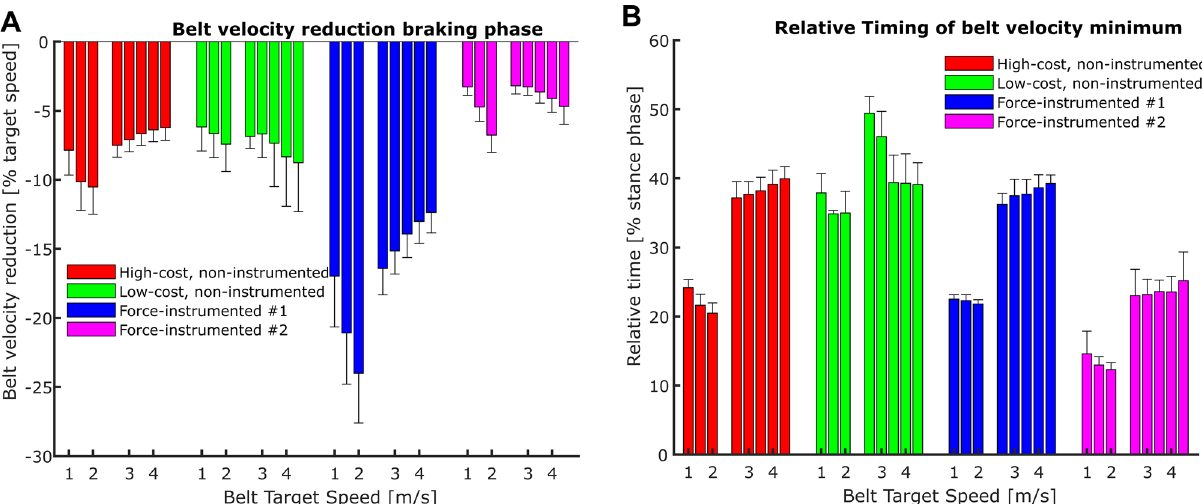
Figure 5. Treadmill belt velocity reduction (mean ± standard deviation) during the braking phase of stance ( A ) and its relative timing ( B ). We separated the bars of the walking speeds (1.0 m/s to 2.0 m/s) from the bars of the running speeds (2.5 m/s to 4.5